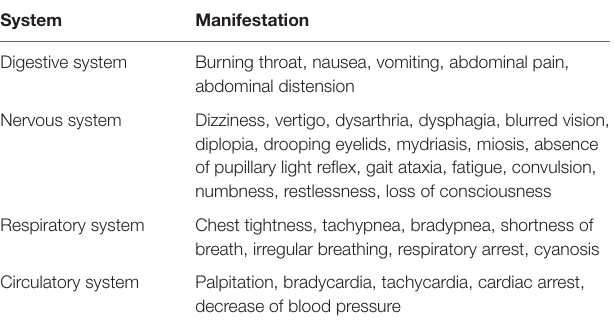
taBLe 2 | Common manifestations being mentioned in the